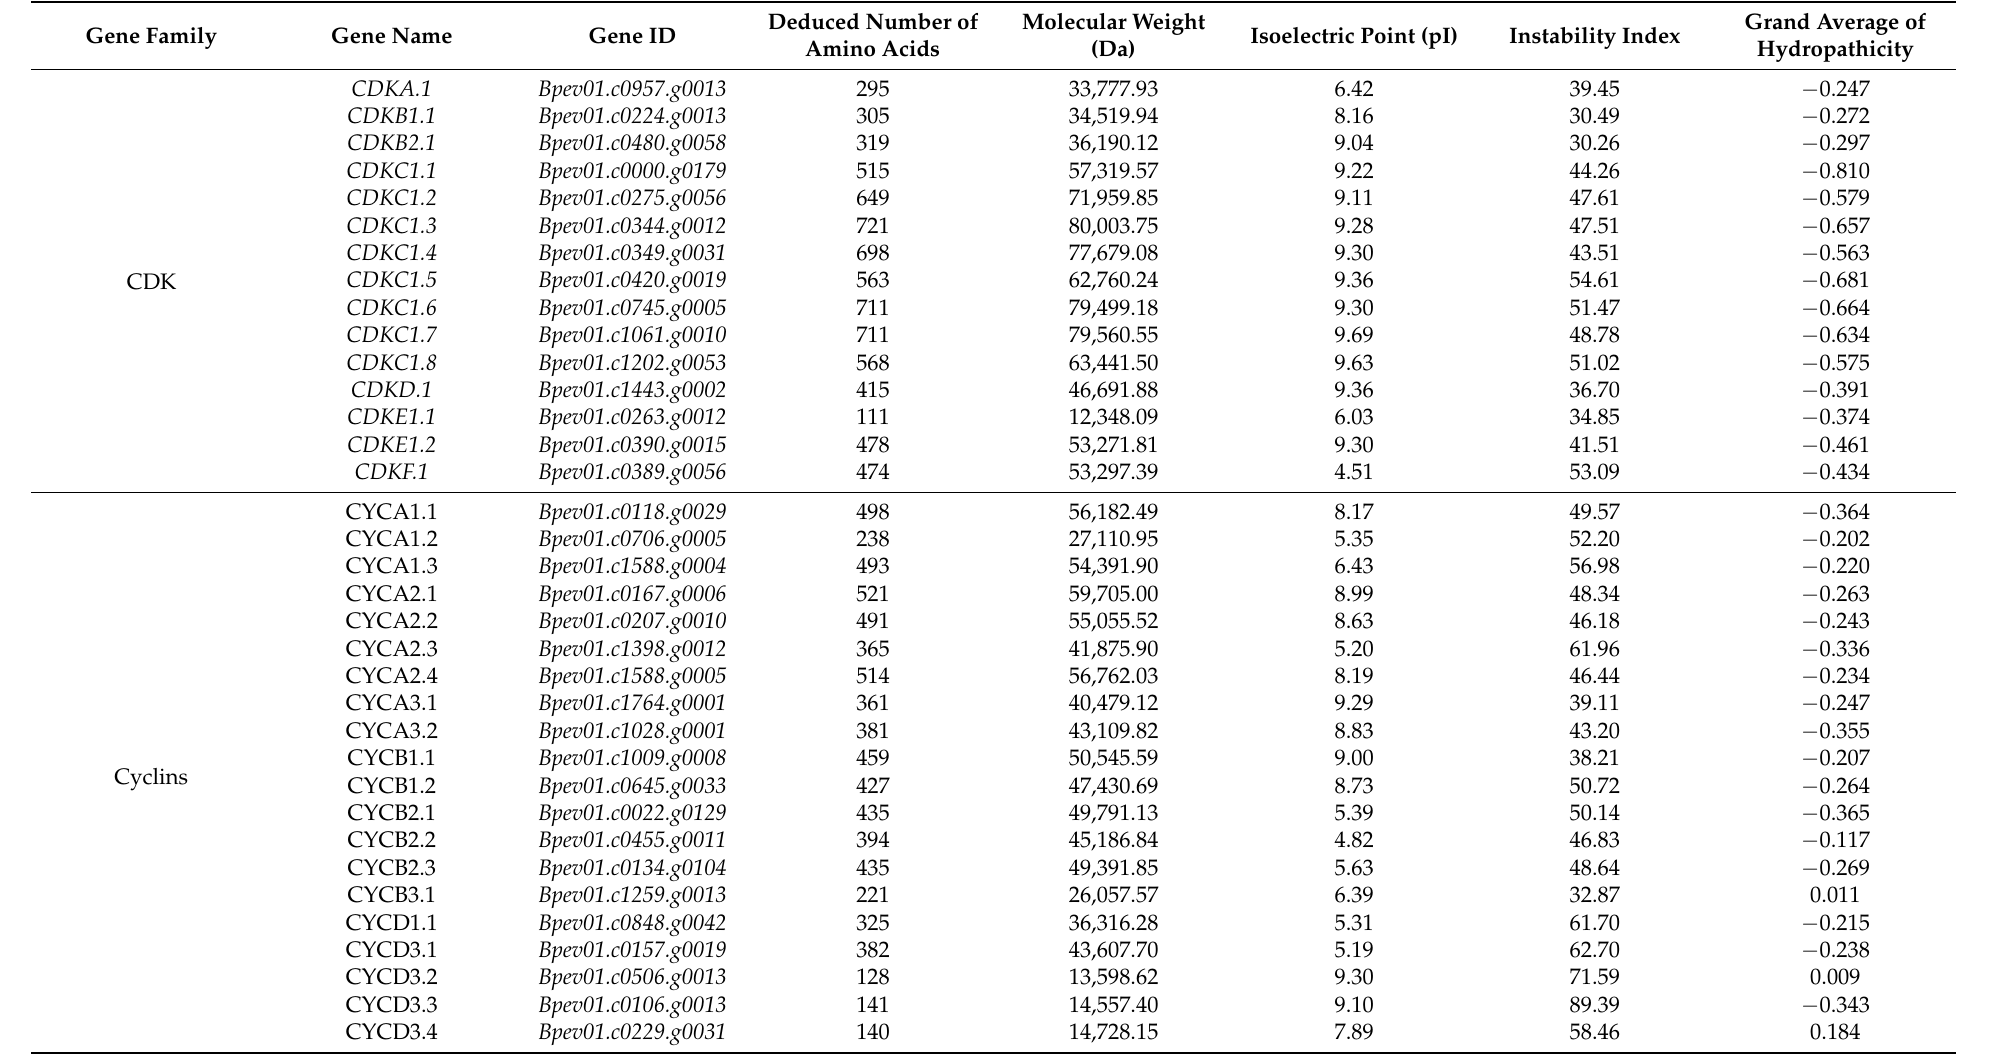
Table 1. Putative cell cycle genes in Betula pendula